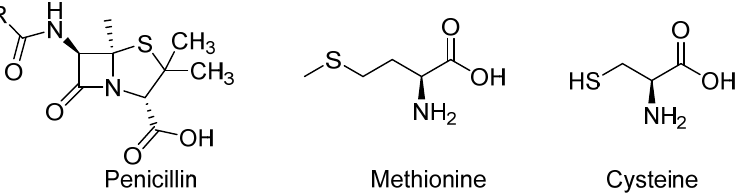
Figure 1. Structure of natural sulfur-containing compounds: penicillin (antibiotic), methionine, and cysteine (amino acids).